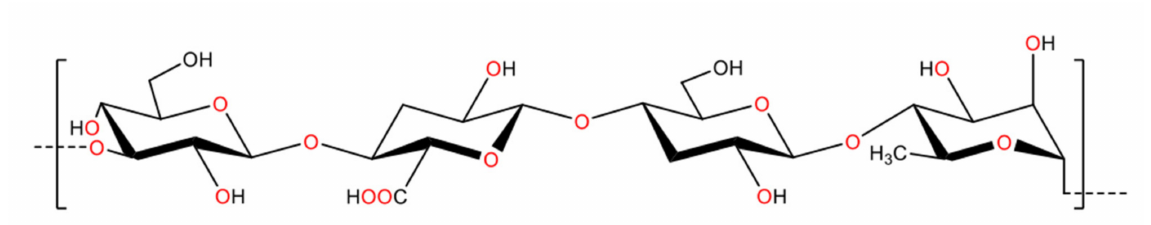
Figure 8. The chemical structure of n repeating units in gellan gum. Reused with permission from Zhang et al. [190]. Copyright © 2021 Elsevier. All rights